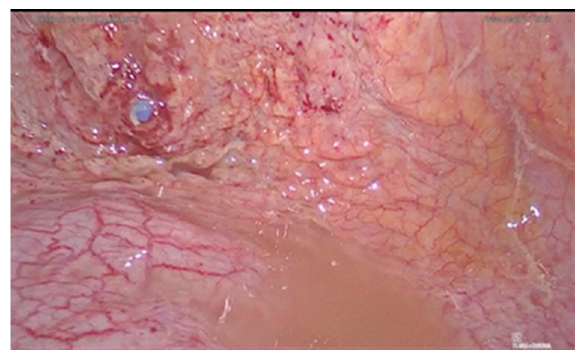
Figure 2. Bladder dome injury.